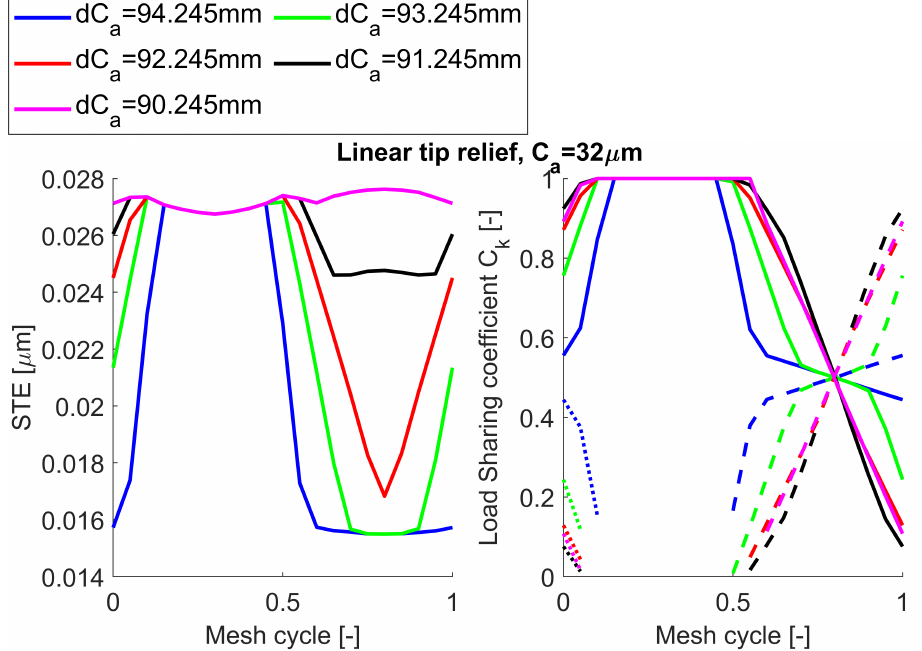
Figure 17. Effect of linear tip relief length of modification on the STE and load